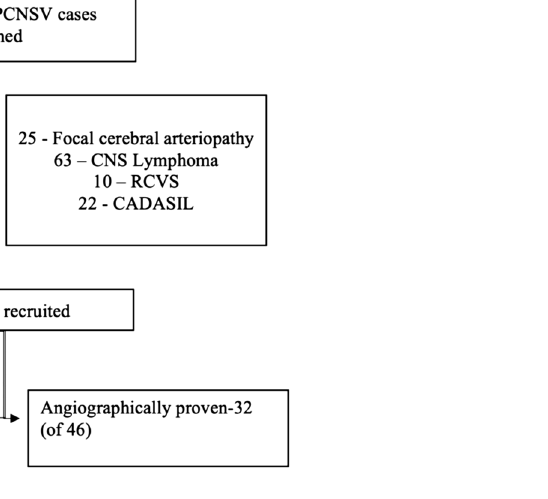
Figure 1. Patient screening and selection for our